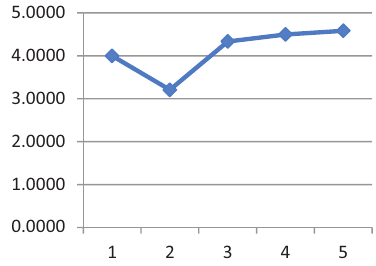
Table 7. Degree of disaster